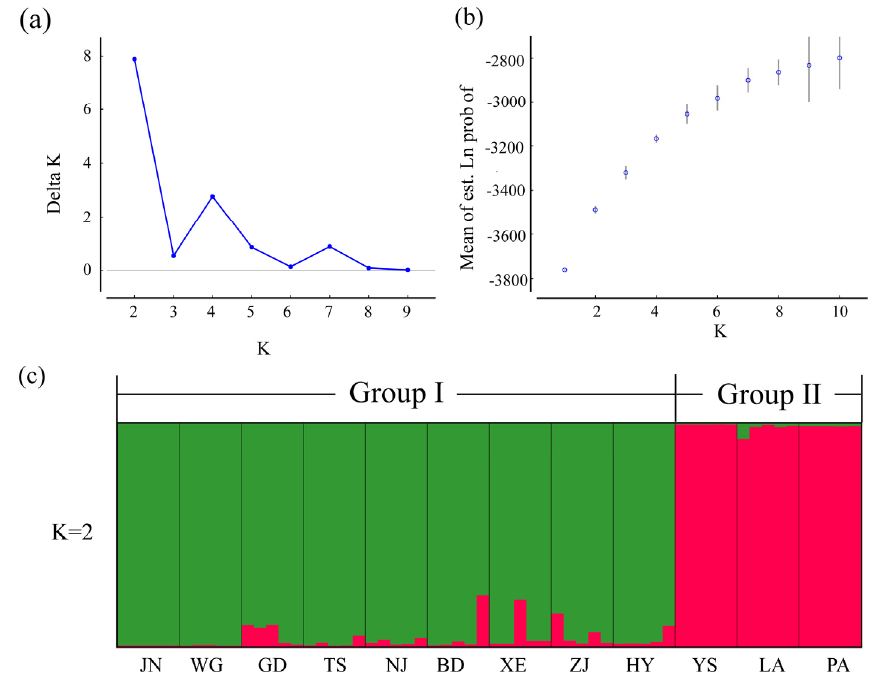
Figure 6. Structure analysis of 60 C. macrophyllum from 12 populations based on 10 EST ‐ SSRs. ( a ) Distribution of Δ K in STRUCTURE analysis. ( b ) The likelihood L(K) values presented for K = 1 − 10. ( c ) Histogram of the STRUCTURE analysis for the model with K = 2 (showing the highest Δ K). Different colors represent genetic stock.